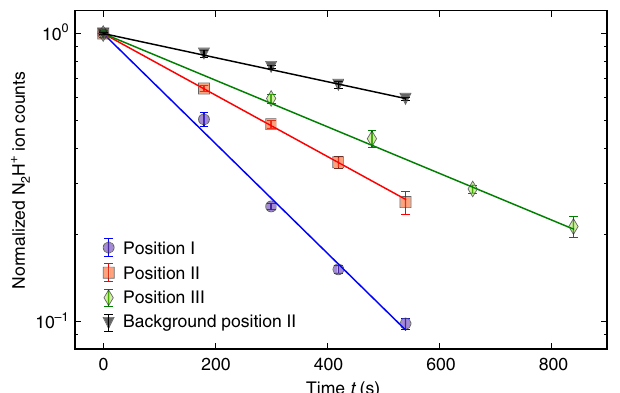
Fig. 3 Reaction-rate measurements at the de fl ection coordinates I – III indicated in Fig. 2b. The data are normalized to the ion signal at time t = 0. The lines represent fi ts to the data according to an integrated pseudo- fi rst- order rate law. The black triangles show an example of a measurement of the reaction rate with background gas at position II for comparison. Error bars correspond to one standard error of four independent